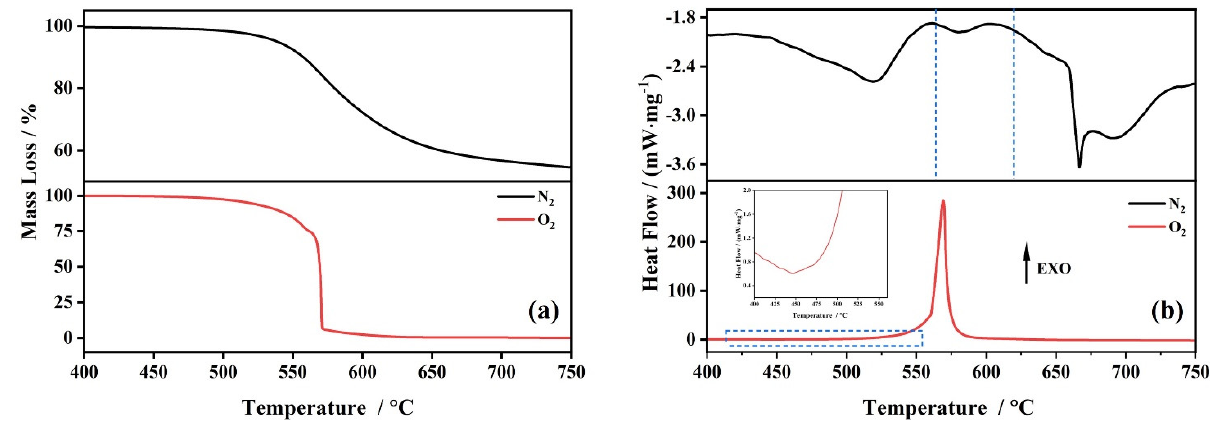
Figure 3. TG ( a ) and DSC ( b ) curves of PI under N 2 and O 2 atmospheres. The DSC curve (the red one) implied that the decomposition of PI is an exothermic reaction in an O 2 atmosphere with a peak temperature of 569 °C, as shown in Figure 3b. There